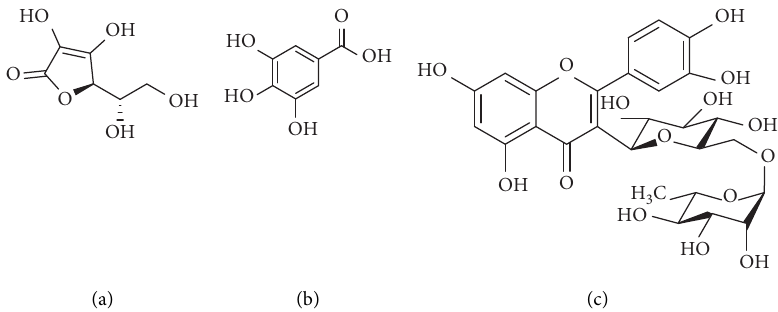
Figure 1: Structural formula of some molecules with antioxidant properties used as reference antioxidants. (a) Ascorbic acid. (b) Gallic acid. (c) Rutin.